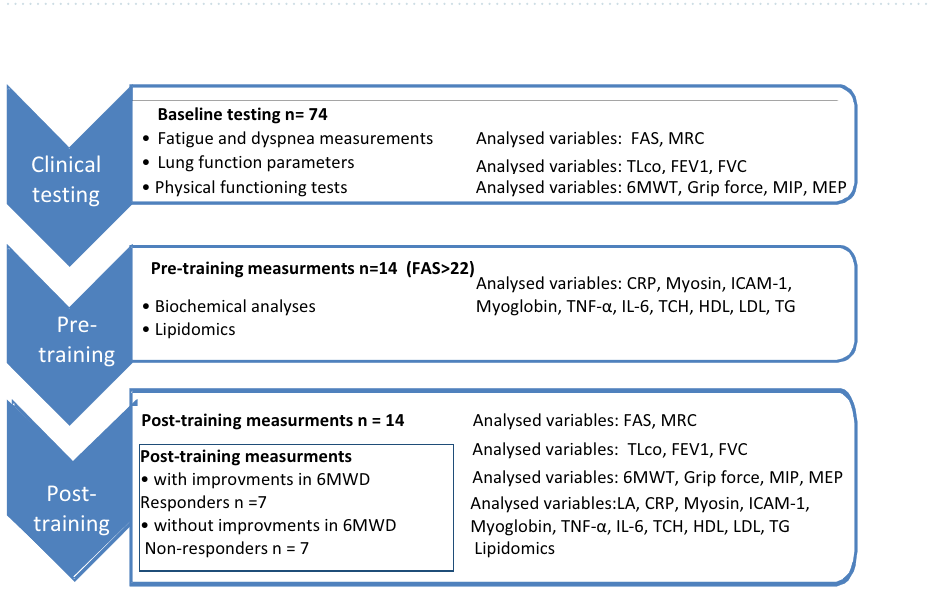
Table 1. Somatic characteristics of the patients with sarcoidosis. BMI Body Mass